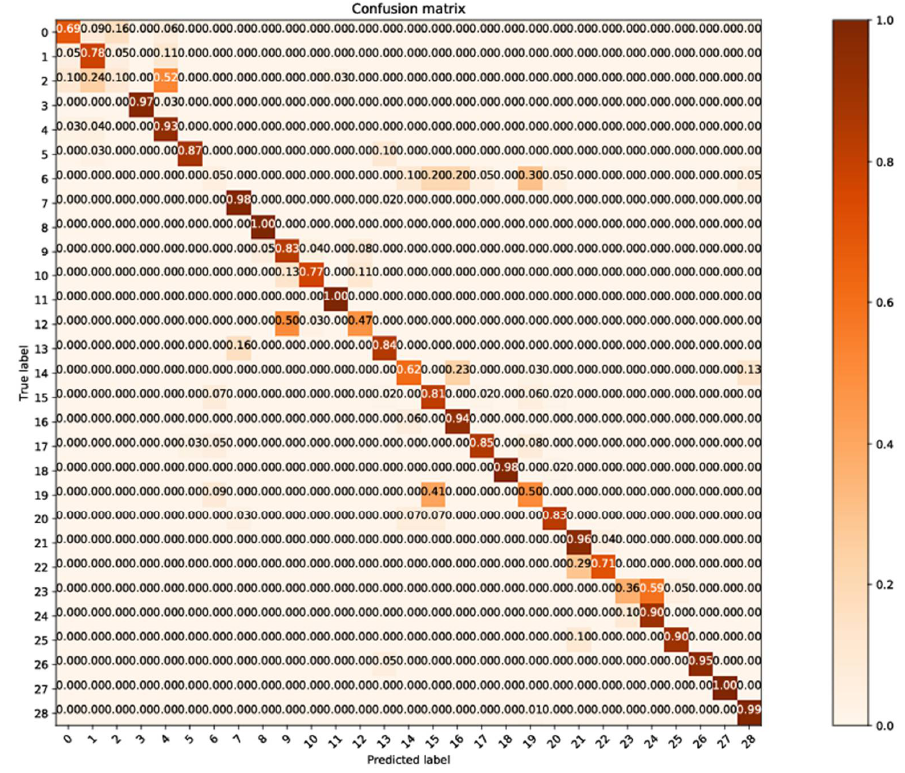
Figure 11. The confusion matrix in the case of the worst classification (10% of the training set).